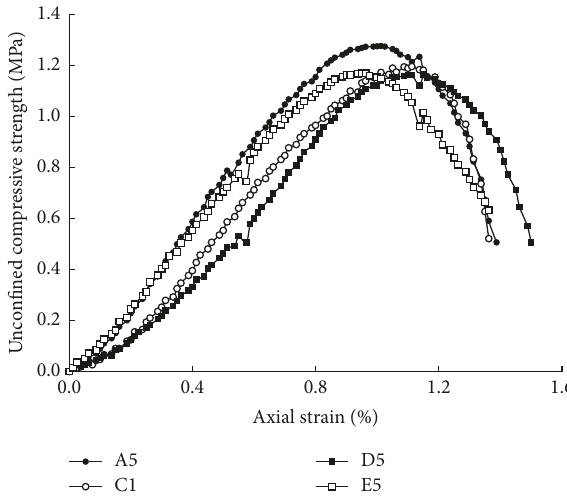
Figure 3: Typical stress-strain curve of simulated soft rock in uniaxial compression.